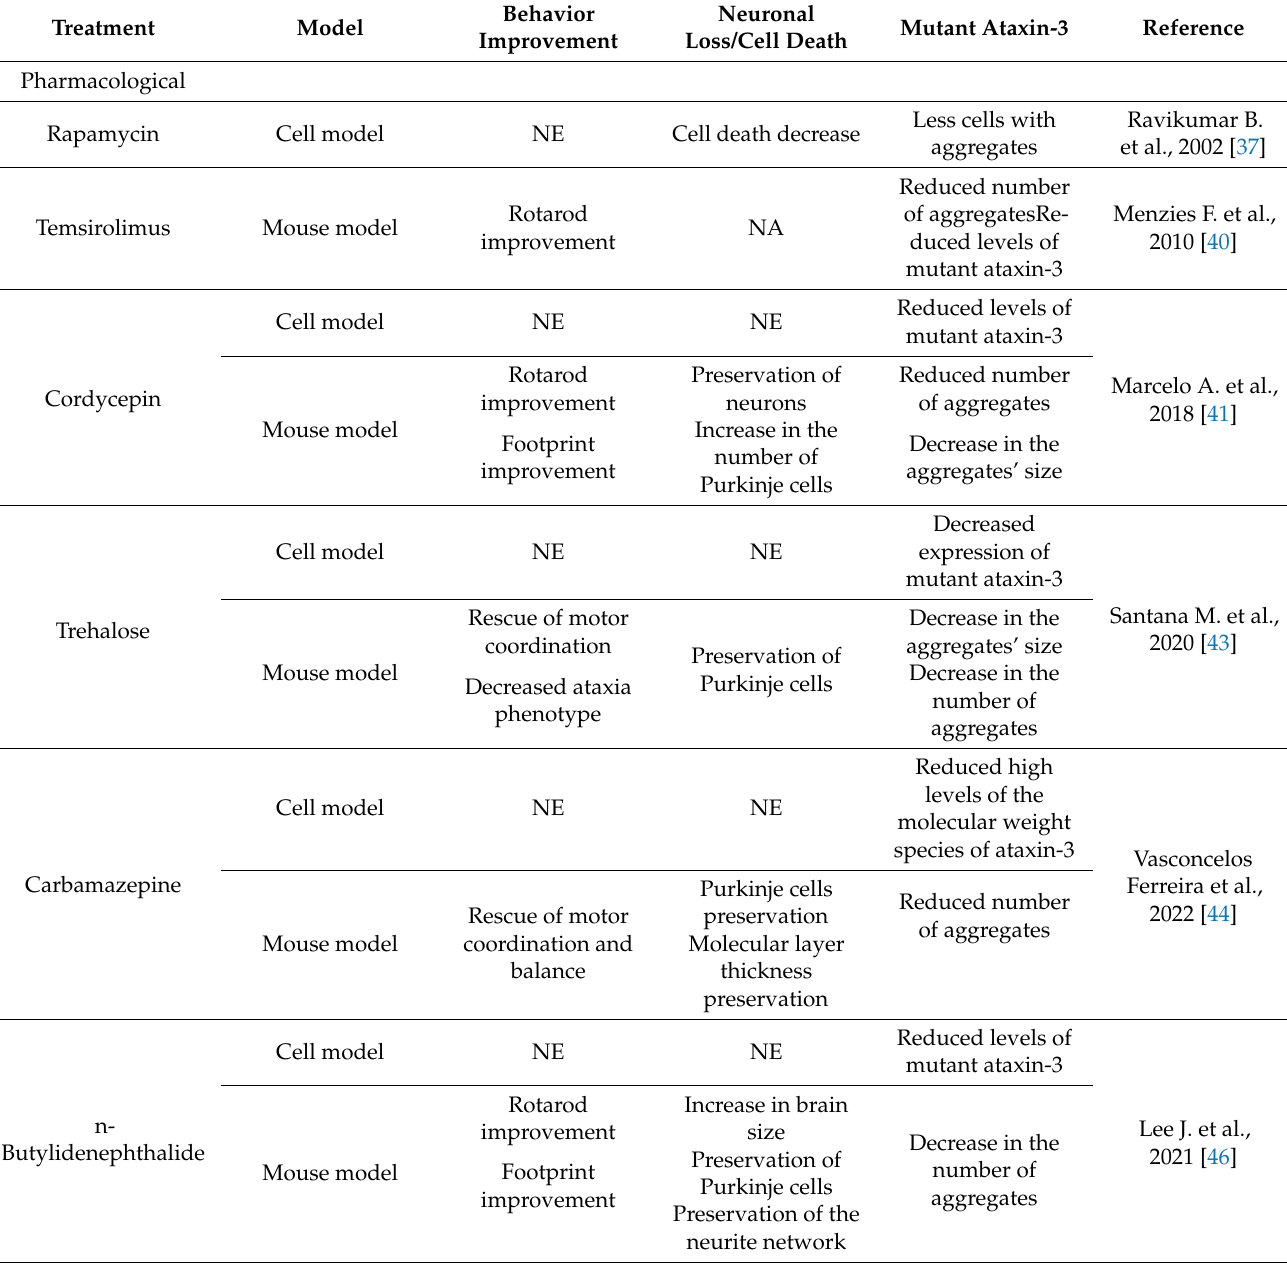
Table 3. Overview of the main outcomes of the selected studies presented in Table 2 using pharmaco- logical compounds to activate